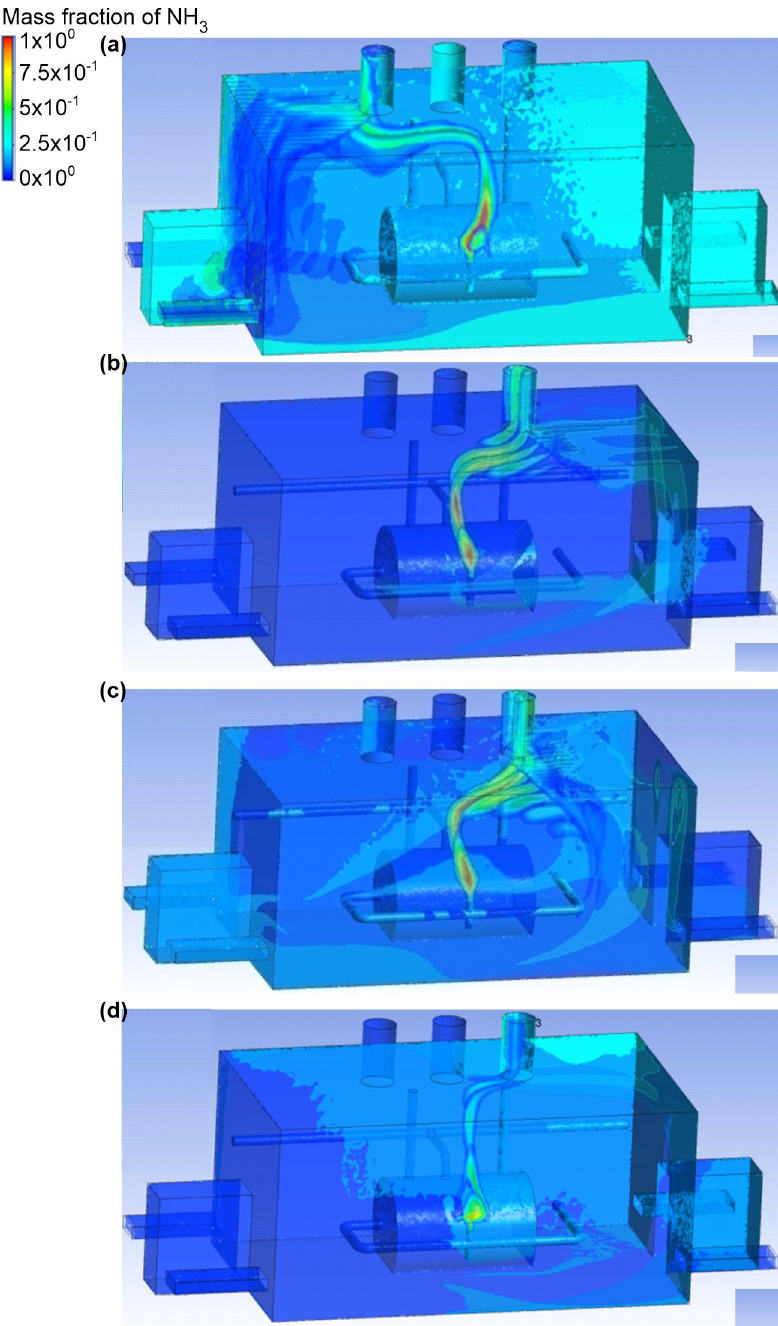
Figure 10. Ammonia distribution in the engine room for: ( a ) scenario A, ( b ) scenario B, ( c ) scenario C, and ( d ) scenario D.